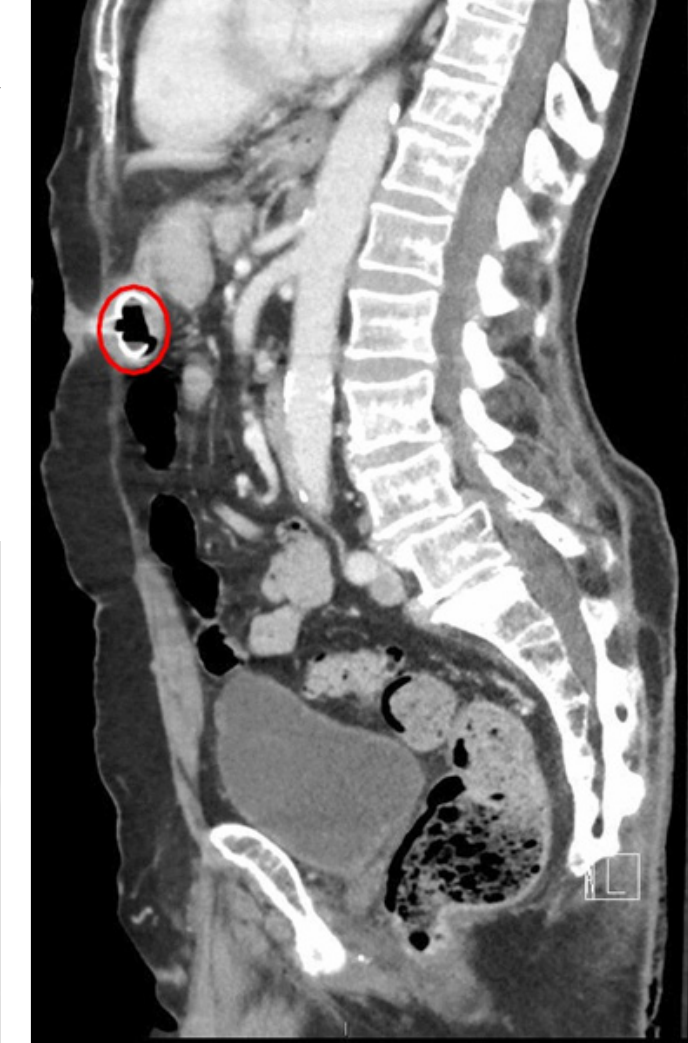
Figure 1. Cross section showing erosion into bowel wall (circle). Figure 2. Sagittal section showing erosion into bowel wall